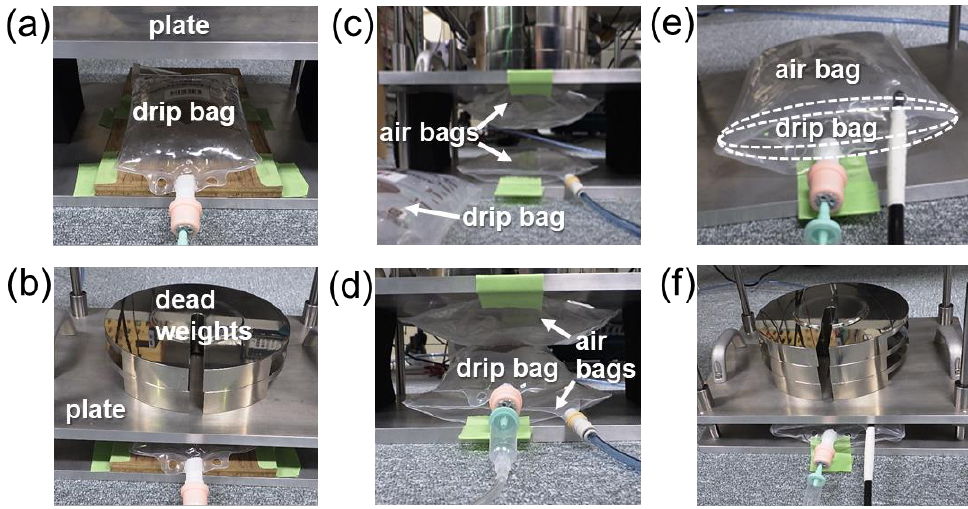
Figure 5. Prototype FIX-ROLLER. ( a ) A vacuum piston cylinder, whose actual orientation (vertical position) is shown in ( c ), pulls and rotates a rolling mechanism by a wire. ( b ) An exterior view of the prototype. ( c ) An interior view of the prototype mounted with a drip bag. ( d ) The rolling mechanism is locked at the standby position by an interior-mounted rachet gear tooth (not visible in ( c )). The rolling mechanism is unlocked by turning a toggle switch at the exterior side panel. ( e ) The rolling mechanism is reset to the standby position using a hexagonal wrench.